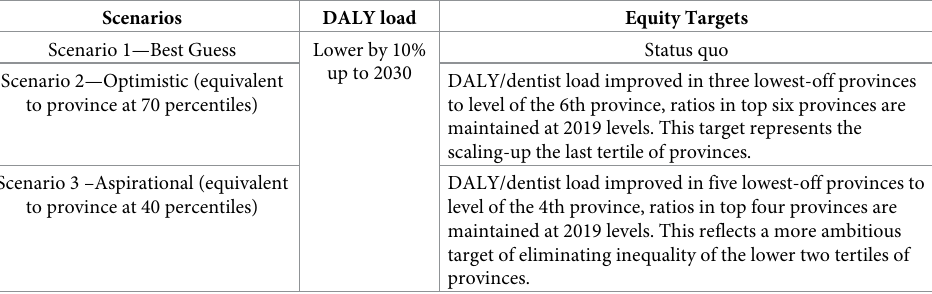
Table 1. Shortfall of dentists (including specialists) as per three equity target based